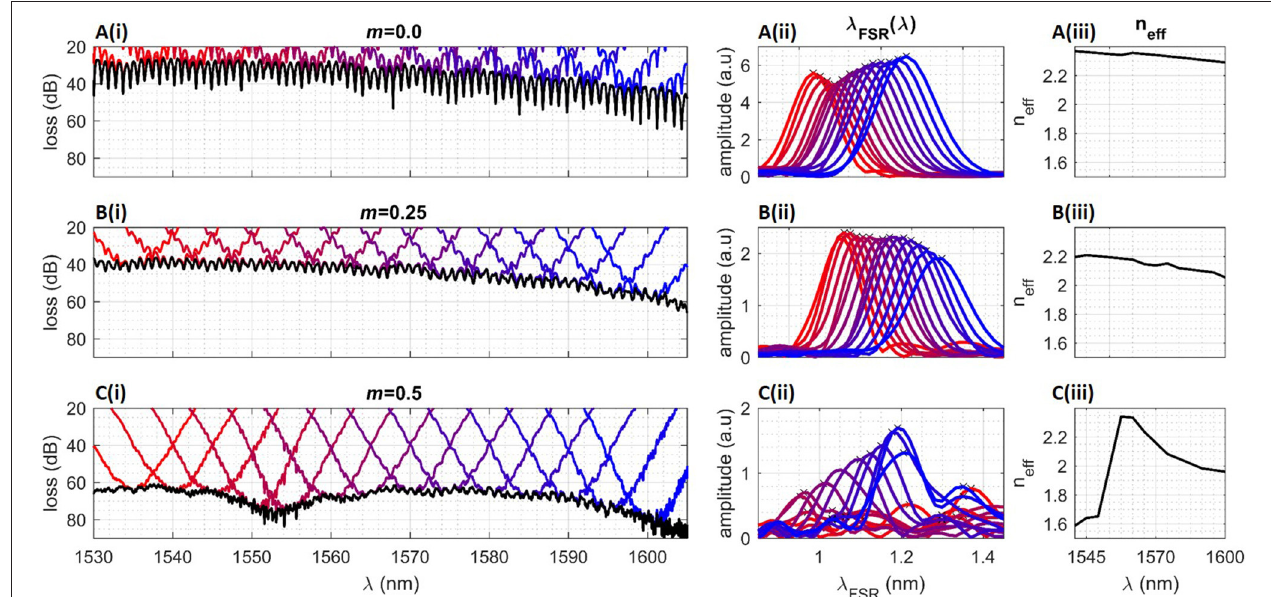
FIGURE 9 | Transmission spectrum (black) with overlaid Gaussian apodized spectra centered on λ = 1,540–1,605 nm (red to blue lines) for a MZI device [( 1 L arm ) = 542 µ m] incorporating on the “active” arm a strip-waveguide (Ai) , a m = 0.0 fin-waveguide (Bi) , or a m = 0.5 fin-waveguide (Ci) . λ FSR for each Gaussian apodized spectrum in the corresponding device are shown in (Aii,Bii,Cii) . (Aiii,Biii,Ciii) Show the calculated n eff ( λ ) based on corresponding λ FSR